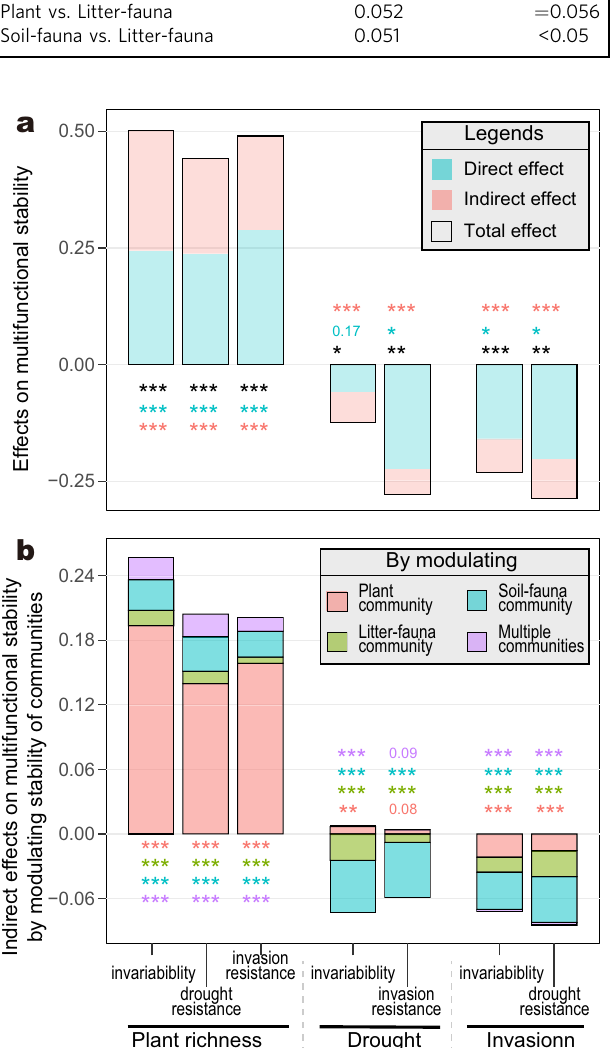
Fig. 3 Effects of plant richness, drought and invasion on multifunctional stability. a Total, direct, and indirect effects on multifunctional stability. b Indirect effects on multifunctional stability by modulating the stability of plant, litter-, and soil-faunal communities. Stack bars are the unbiased estimates of effects generated by bootstrapping ( n = 10,000). Asterisk or number near stack bar indicates signi fi cance of difference from 0 (decimals p > 0.05, * p < 0.05, ** p < 0.01, *** p < 0.001; Mantel-like permutation test with 10,000